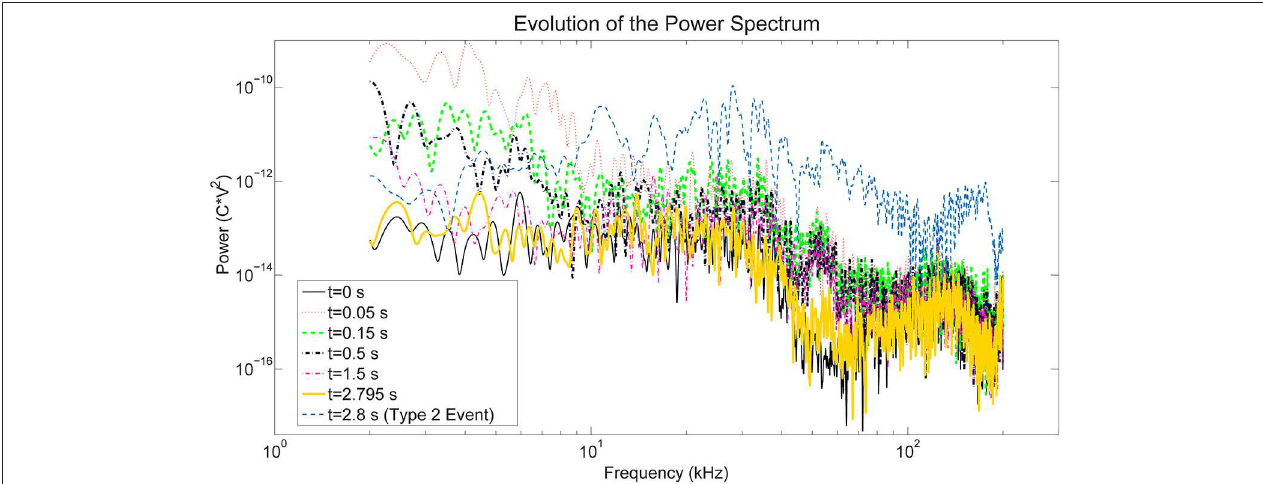
FIGURE 11 | The evolution of power spectrum over different time windows are presented. With time, the power is decreasing until finally reaching back to the initial level. However, during Type 2 events the spectrum has a completely different signature.